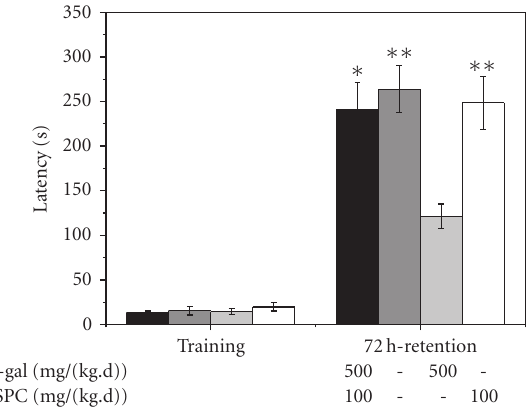
Figure 2: Performance in the passive avoidance test. All values are expressed as means ± SEM ( n = 8) . ∗ P < . 05, ∗∗ P < . 01, ∗∗∗ P < . 001 versus D-gal model. Scale bars: 100 μ